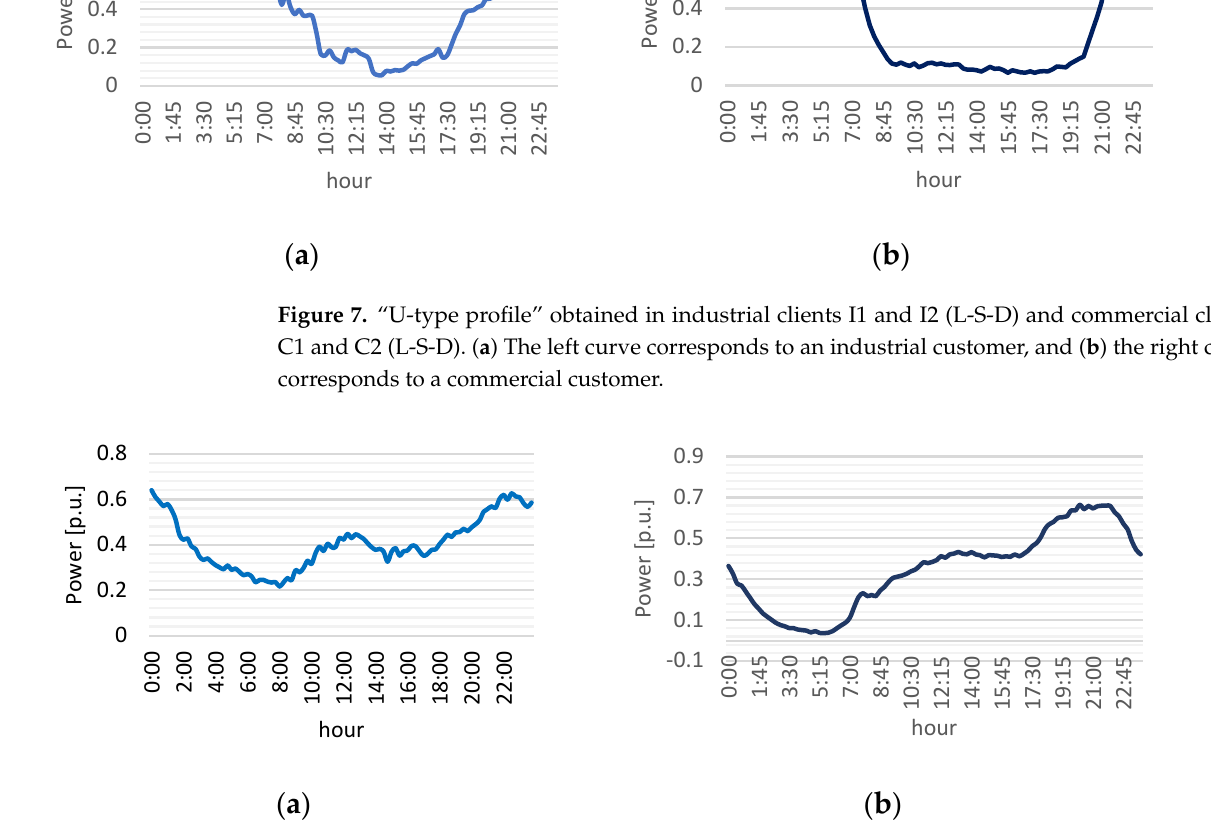
( b ) Figure 9. “Slim mount profile” obtained in industrial clients I1 and I2 (S) and in commercial clients C2 (S). ( a ) The left curve corresponds to an industrial customer, and ( b ) the right curve corresponds to a commercial customer. ( a ) ( b ) Figure 10. “W-type profile” obtained in industrial clients I1 (D) and commercial clients C2 (D). ( a ) The left curve corresponds to an industrial customer, and ( b ) the right curve corresponds to a com- mercial customer. The Mount-type profile (industrial client) (Figure 6) represents a working day with a more constant behavior during most of the day, starting at 08:00 h and having peaks in demand around noon. Unlike the M-type profile, this profile does not suffer a decrease in demand at midday, which implies that they are industries or businesses that have active processes throughout the working day. The U-type profile, Figure 7, represents an unusual behavior, more similar to the con- sumption profile of public lighting, because it shows high consumption at night and low consumption during the typical working day. This profile represents evidence of high levels of night demand due to lighting and/or security systems.